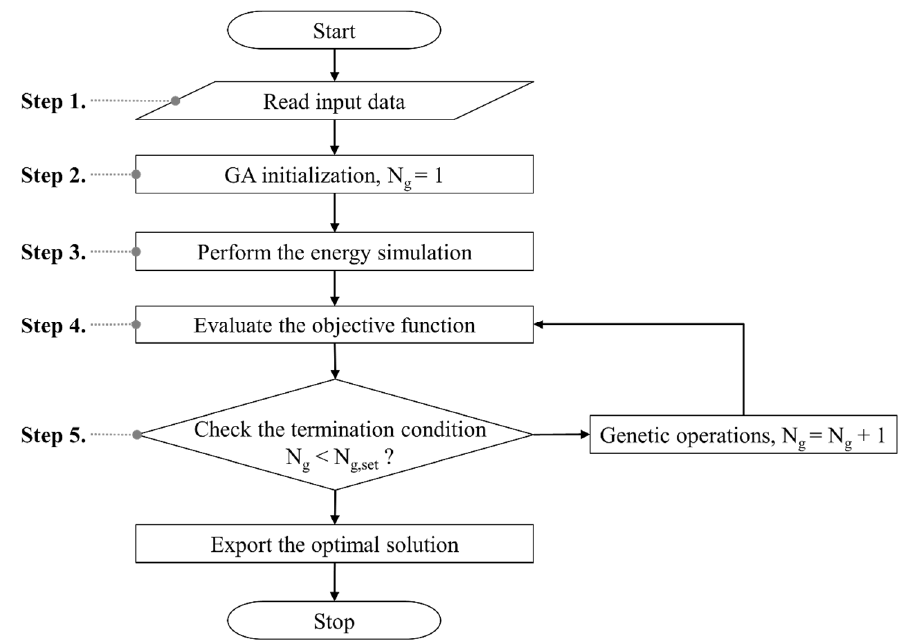
Figure 2. Flowchart of the proposed optimization